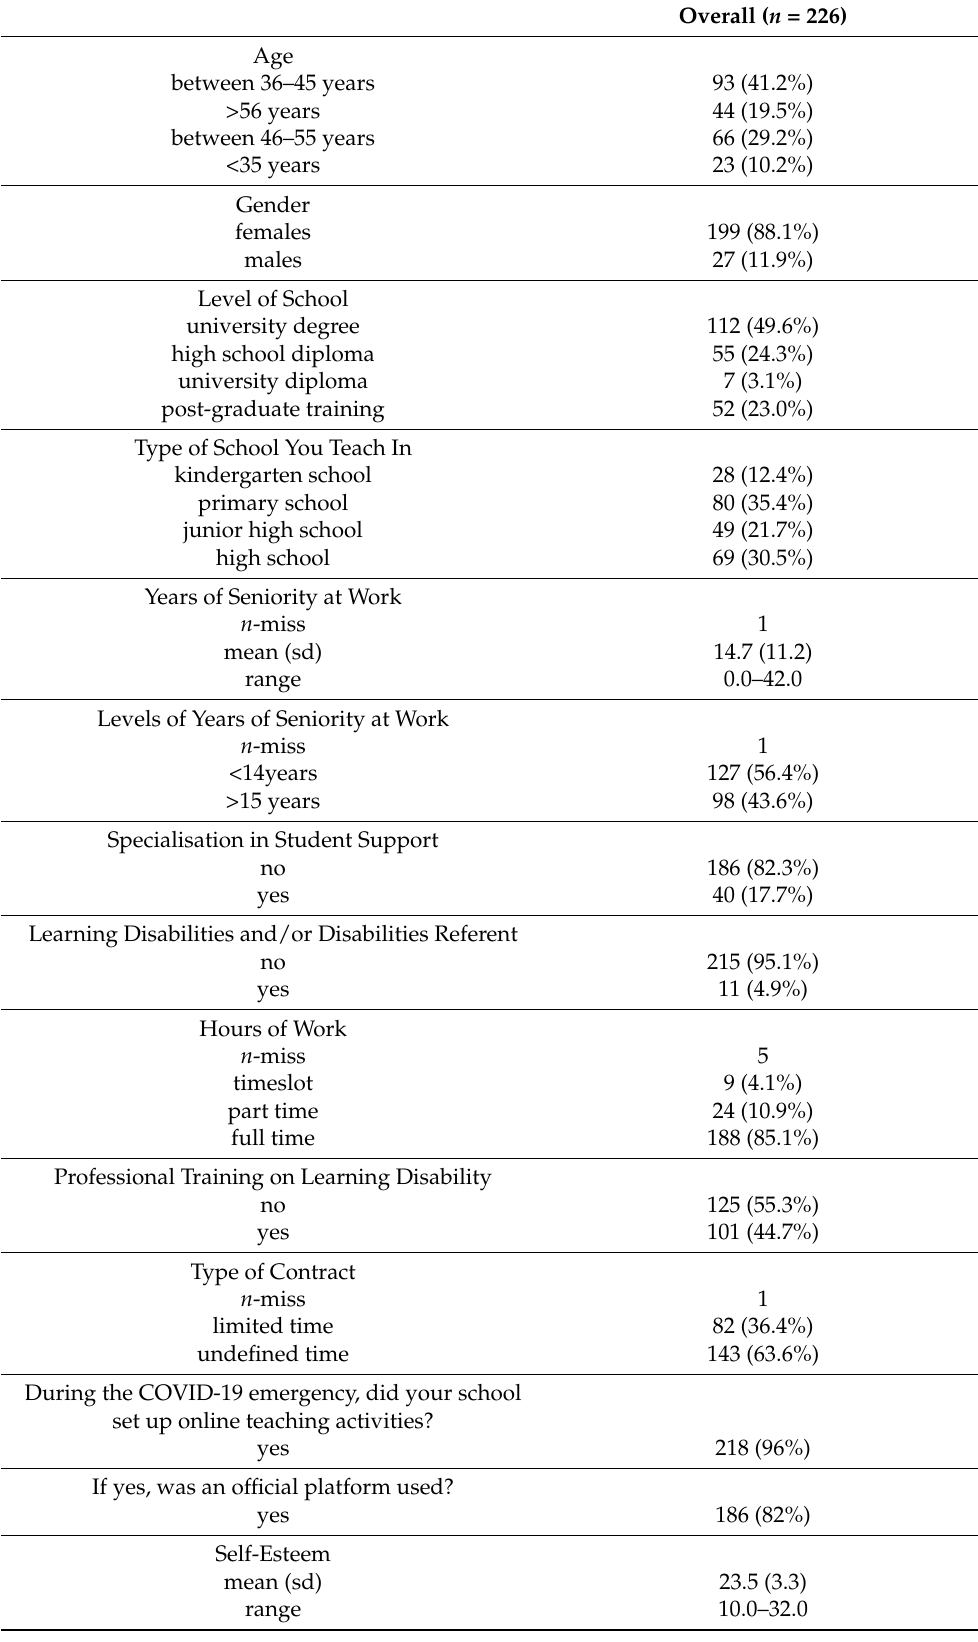
Table 1. Descriptive statistics of the assessed